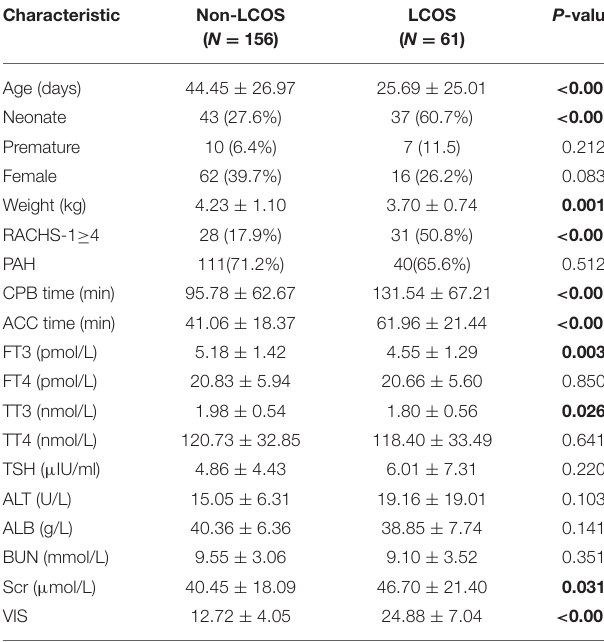
TABLE 1 | Characteristics of enrolled patients with congenital heart disease. Characteristic